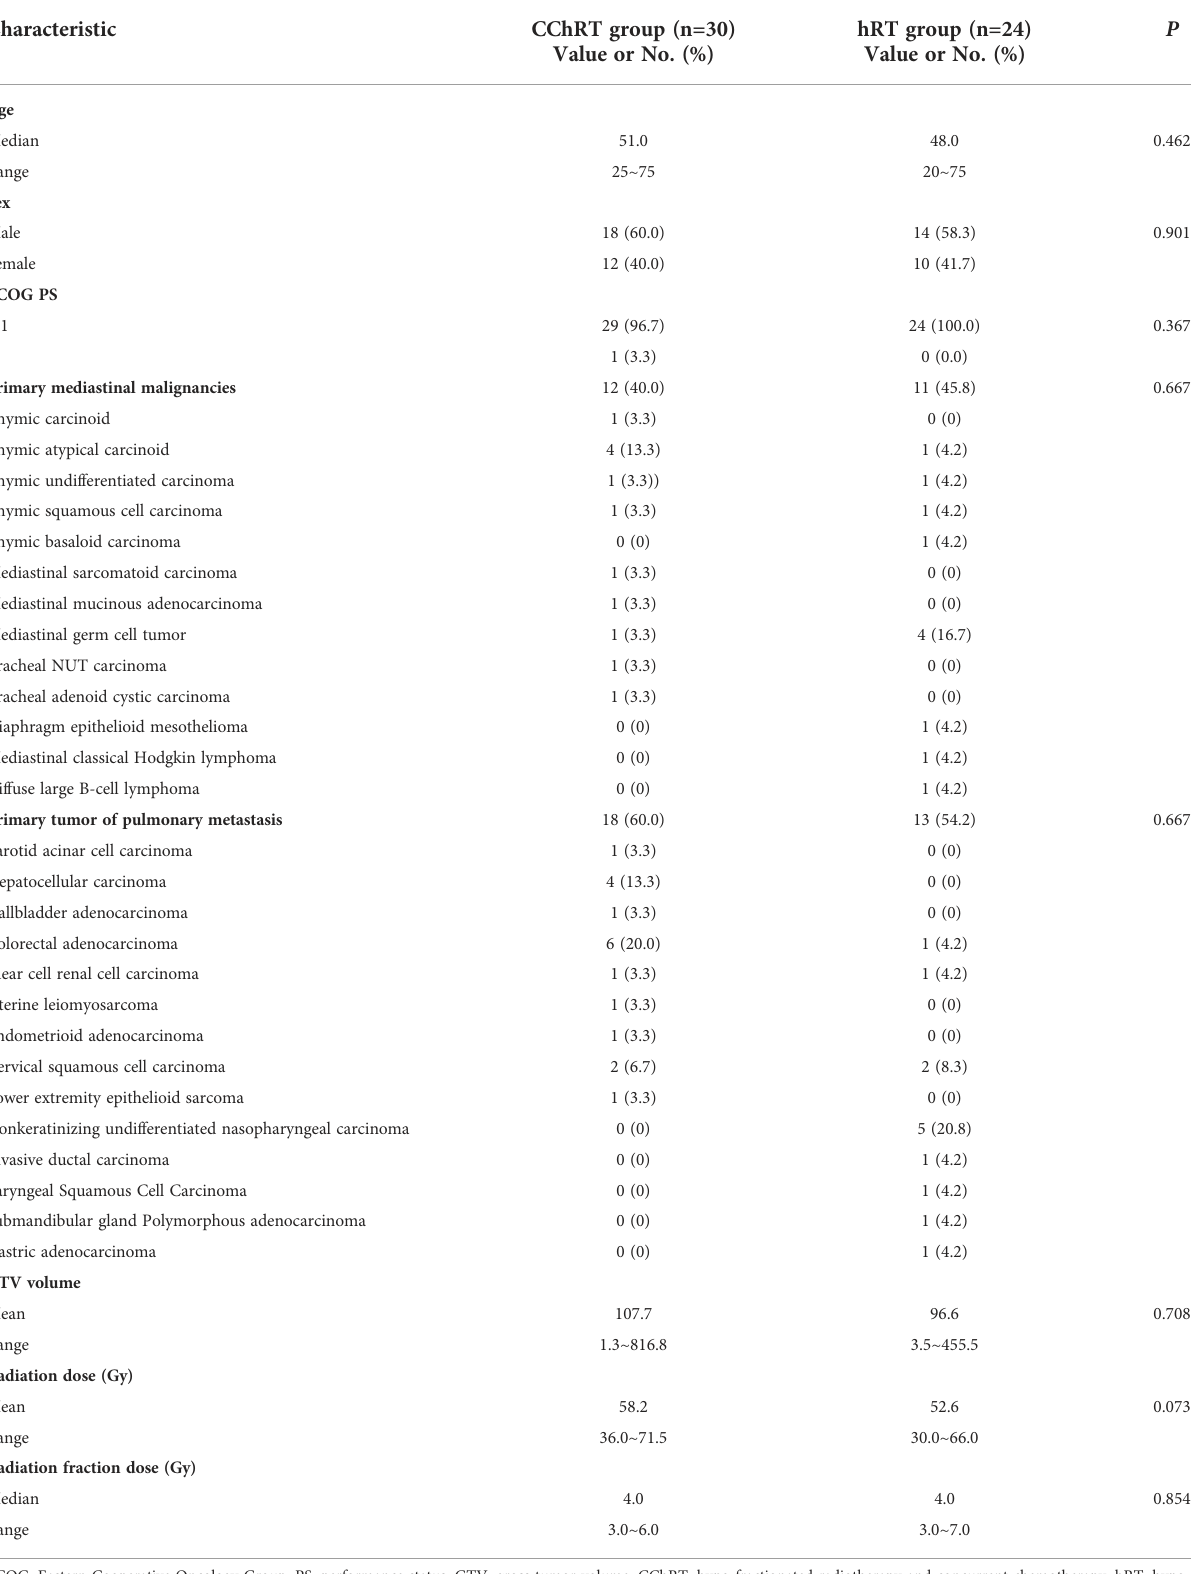
TABLE 1 Baseline Characteristics